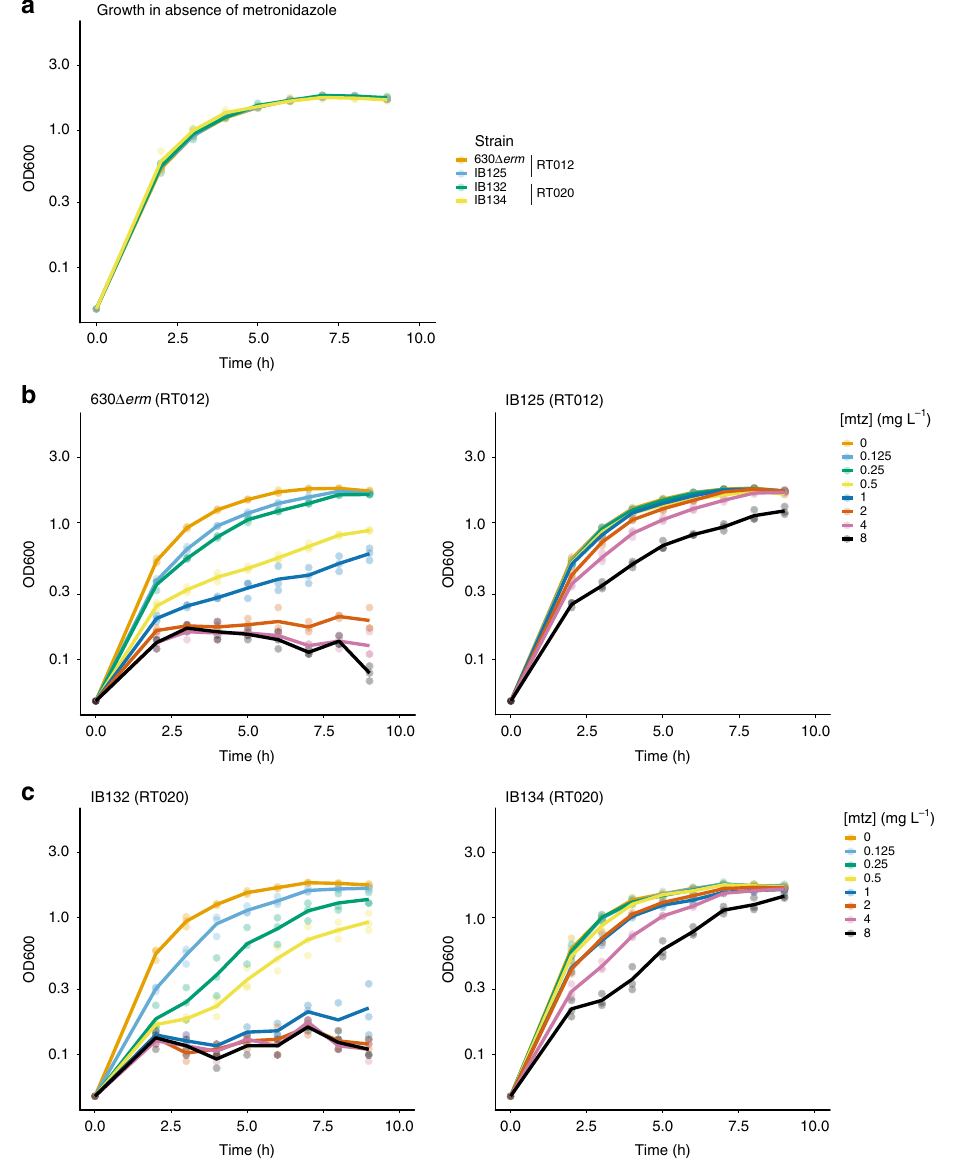
Fig. 8 The effects of carriage of pCD-METRO on growth. a Growth as monitored by an increase in optical density at 600 nm (OD600) of various strains in the absence of metronidazole. b Growth of RT012 strains in the presence of various concentrations of metronidazole [mtz]. c Growth of RT020 strains in the presence of various concentrations of metronidazole [mtz]. Individual measurements are shown as semi-transparent dots. The median of the replicates is shown as a solid line. Source data are provided as a Source Data fi